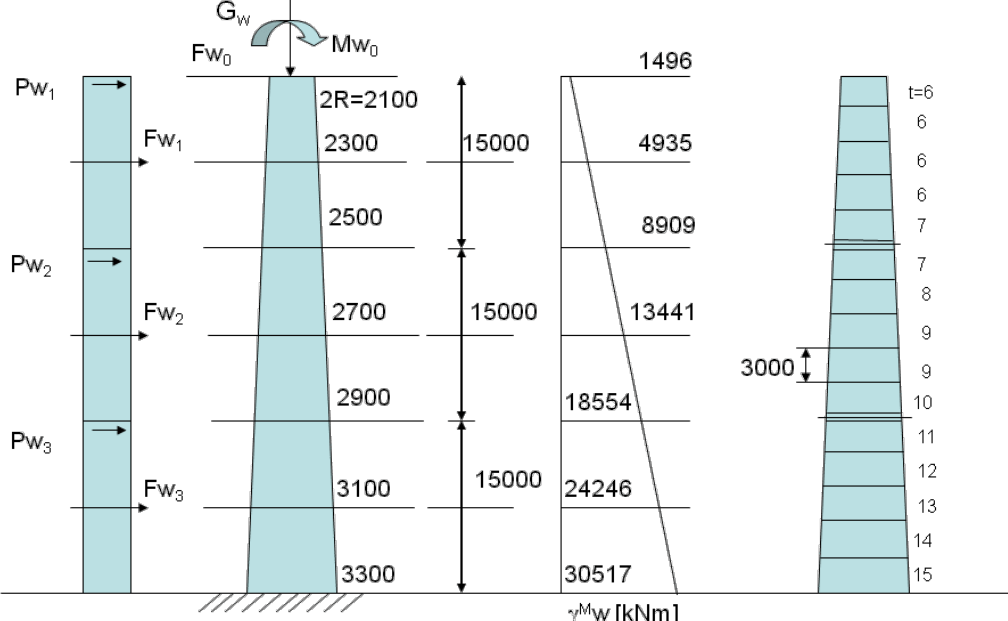
Figure 3. The 45 m wind turbine tower model used in